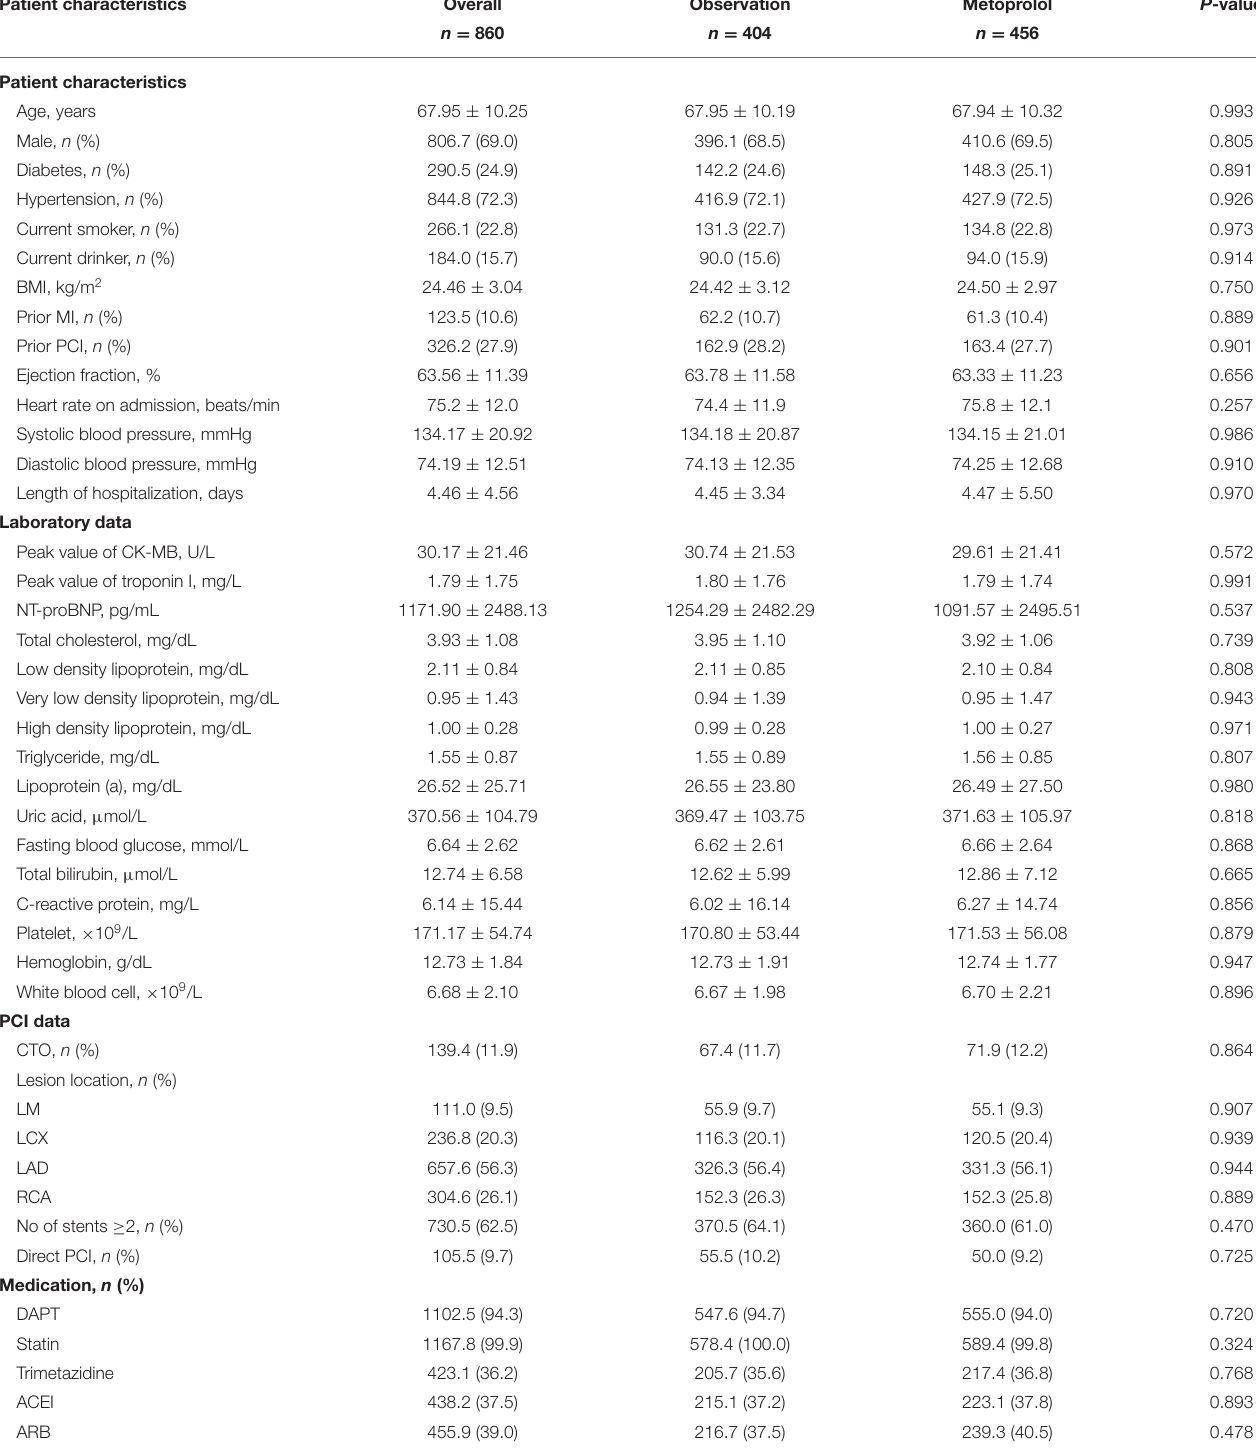
TABLE 2 | Baseline characteristics of IPTW-adjusted